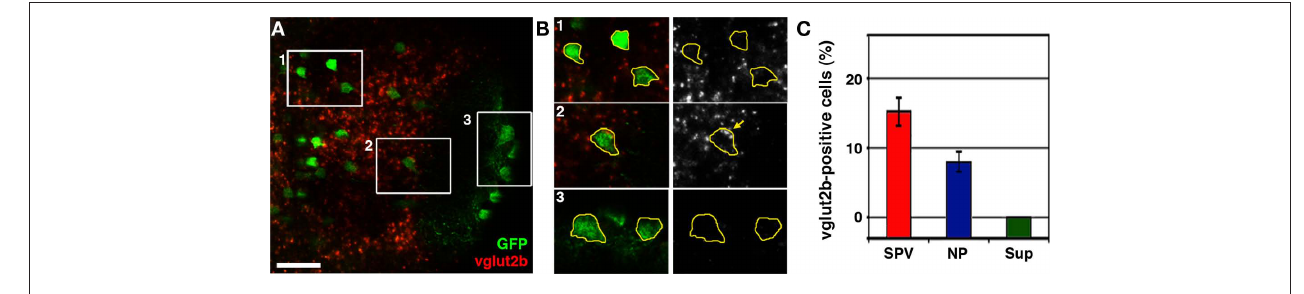
fluorescence was used to trace cell body outlines. Note strong, punctate vglut2b in situ signal in the perinuclear region of cell body in B2. In contrast, the majority of cells in the SPV (B1) and all cells in the superficial NP (B3) lacked this punctate vglut2b mRNA signal. (C) Quantification of glutamatergic